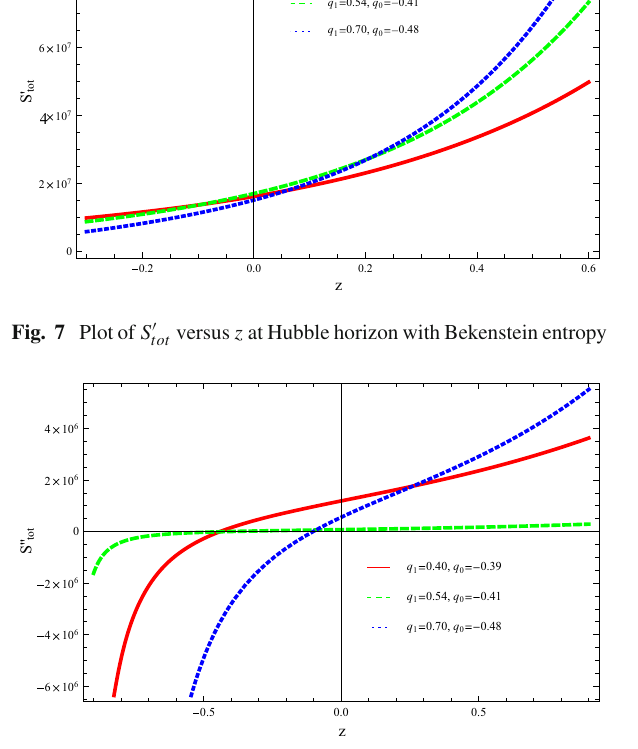
Fig. 11 Plotof S (cid:5) tot versus z atHubblehorizonwithBekensteinentropy